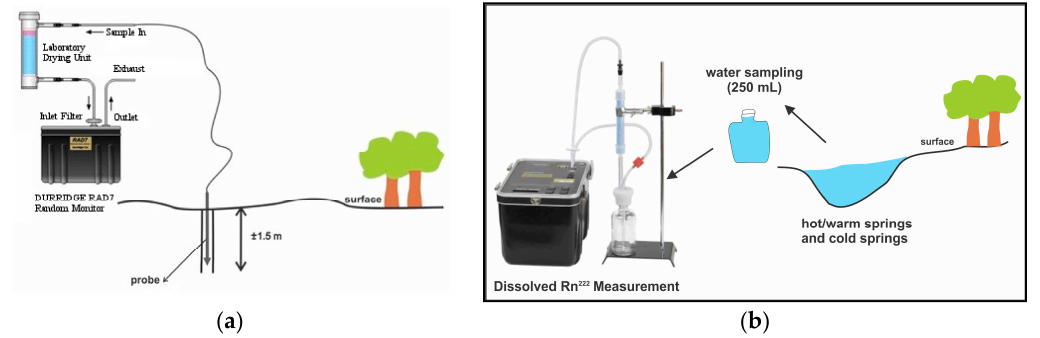
Figure 6. In situ radon measurement methods. ( a ) Schematic model of radon measurement in soil; ( b ) dissolved radon measurement using a 250-mL glass bottle.